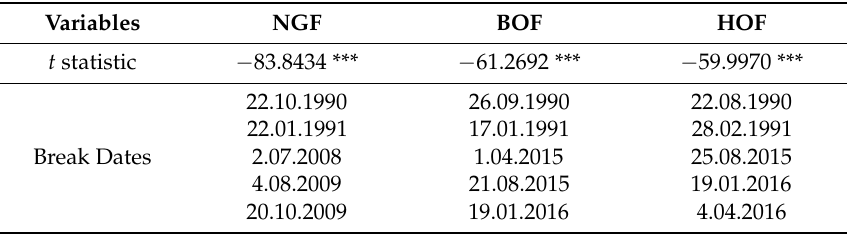
Table 1. Kapetanios m-Breaks Unit Root